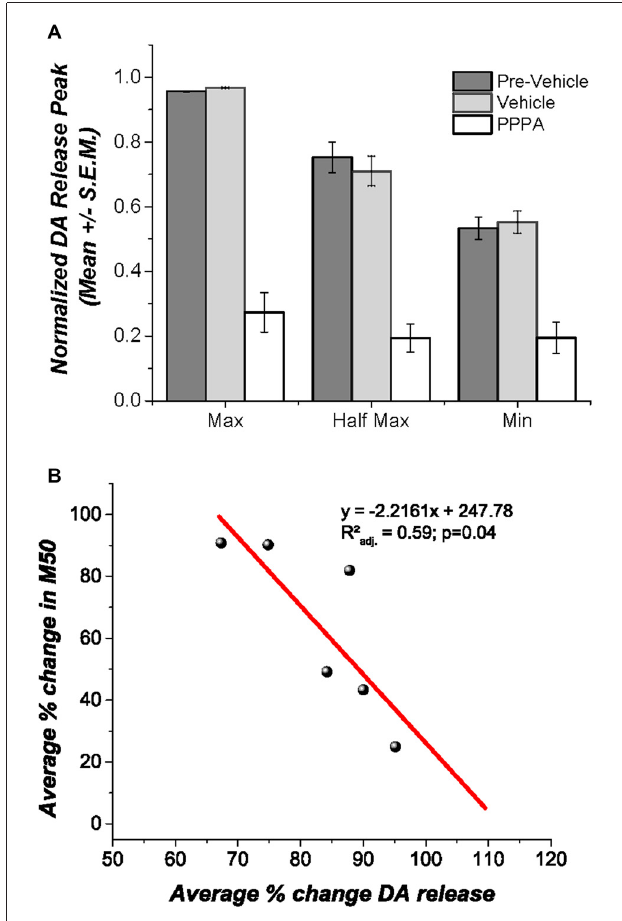
FIGURE 5 | Effects of intra VM PPPA injection on DA release. (A) Under urethane anesthesia intra VM PPPA injection decreased stimulation-elicited DA release in comparison to measures obtained before and after vehicle injection; this effect was seen at all three frequencies tested. (B) A negative correlation between the drug-induced decrease in stimulation-evoked DA release and the change in M50 was observed. In the behaviorally trained animals, the enhancement in reward effectiveness, produced by VM injection of PPPA covariates with the reduction in DA release; so that the larger the enhancement the greater the DA release reduction.